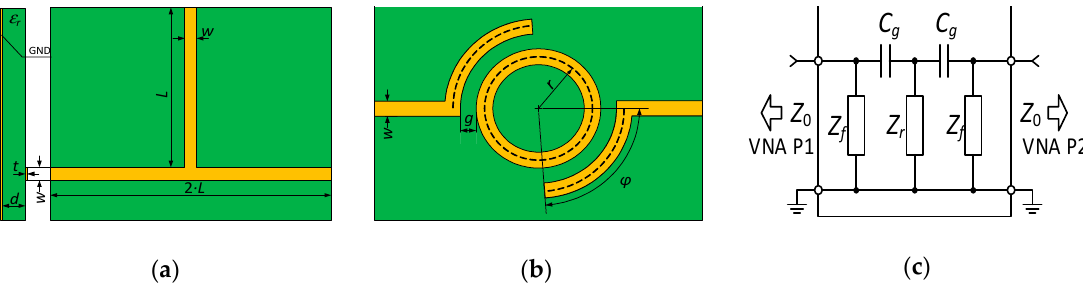
Figure 10. Microstrip resonator models: ( a ) T-resonator; ( b ) Modified ring resonator; ( c ) Equivalent circuit of modified ring resonator.